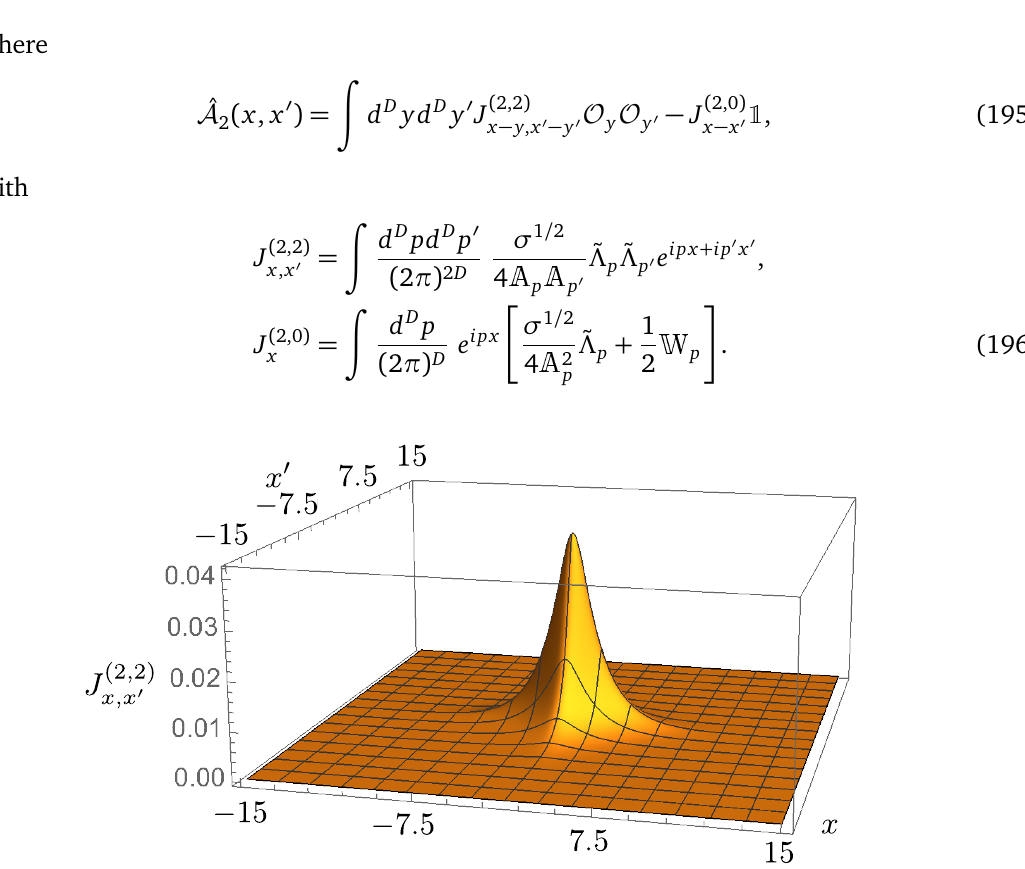
( 2,2 ) as a function of x and x (cid:48) at z = 25 for a system x , x (cid:48)